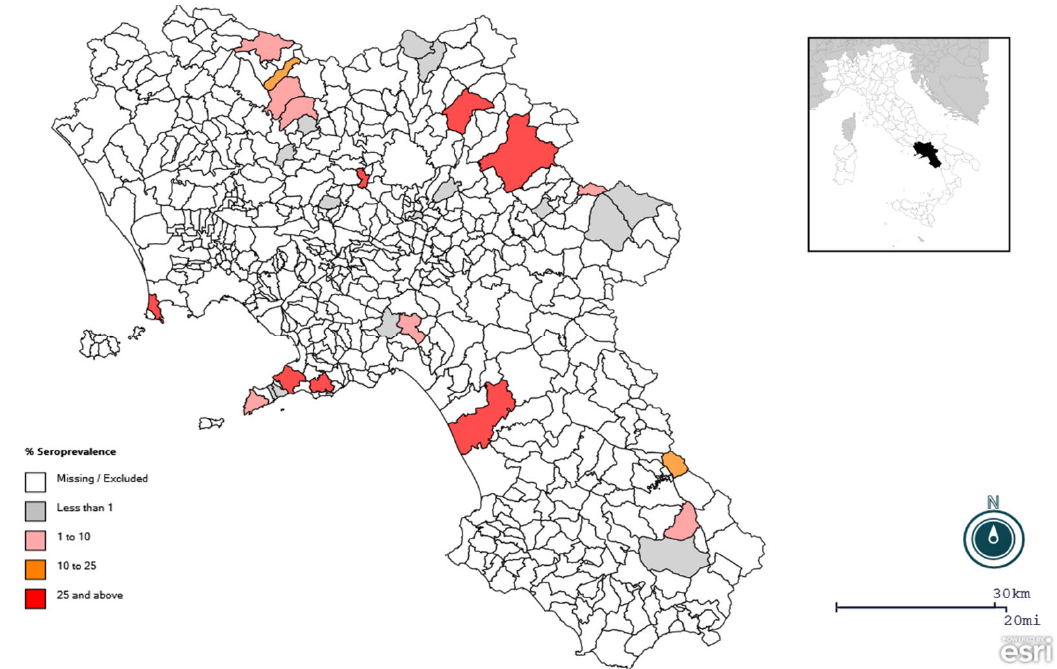
Figure 2. Spatial distribution of positive farms for PRRSV in the pig population in the Campania region, southern Italy. PEDV and PRRSV were found in high concentrations in several districts. Table 2. Univariate analysis (chi ‐ square) of a potential risk factor for PEDV and TGEV seropositiv ‐ ity.